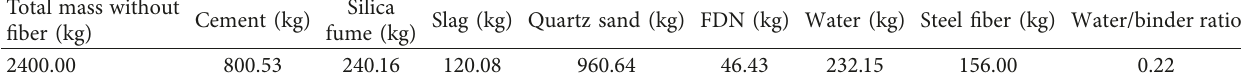
Table 2: RPC mix